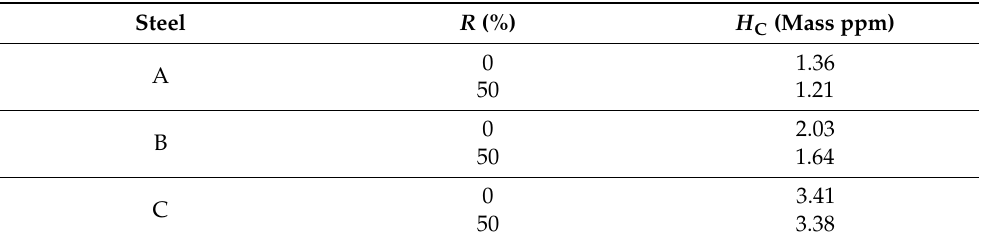
Figure 7. Hydrogen desorption curves of conventional and hot-forged steels A, B, and C charged with hydrogen by a 3% NaCl + 5 g/L NH 4 SCN solution at a current density of 10 A/m 2 for 48 h. R represents reduction ratio. Table 3. Hydrogen concentration ( H C ) of conventional and hot-forged steels A, B, and C. R represents reduction